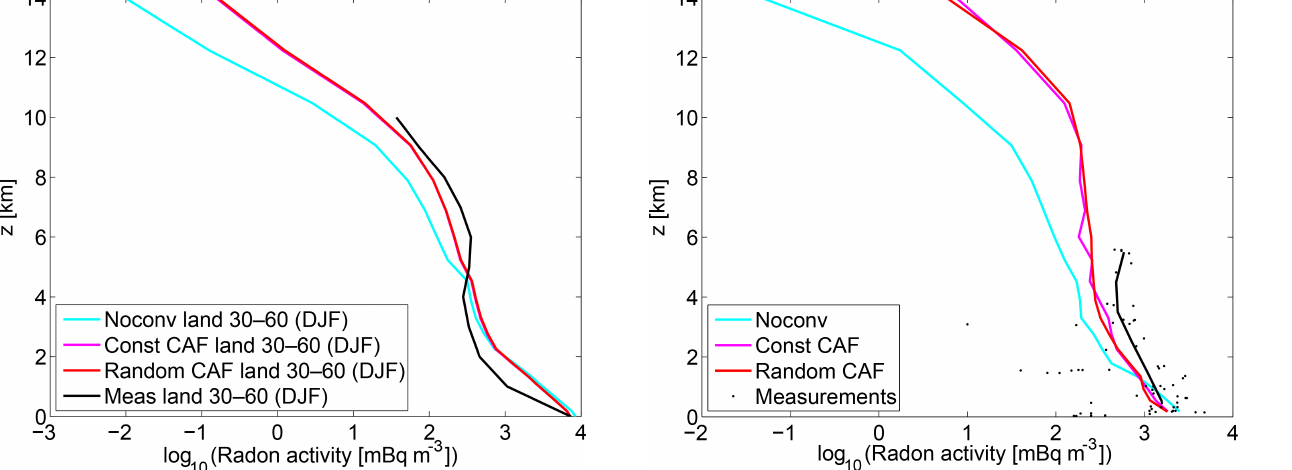
Figure 17. Observed radon from aircraft measurements of the North Atlantic Regional Experiment (NARE) campaign in August 1993 (Zaucker et al., 1996) compared to the simulated radon from our model in the same time period using a bounding box including all measurements. Dots show the single measurements and the solid black line the mean in 1km